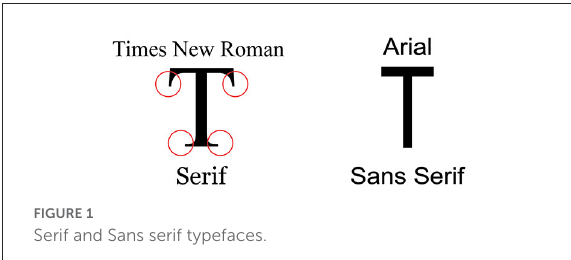
FIGURE1 Serif and Sans serif